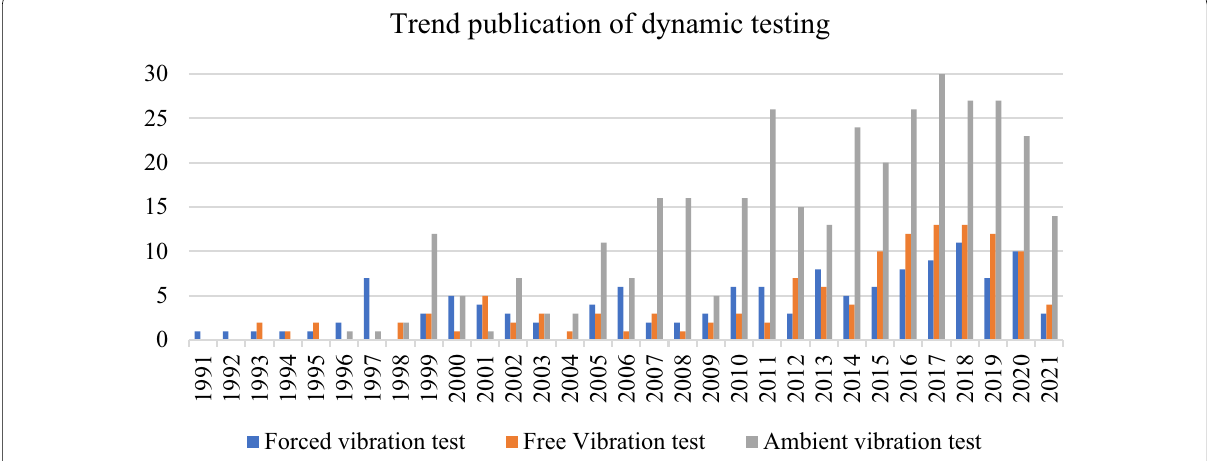
Fig. 6 Trend publication for dynamic testing from